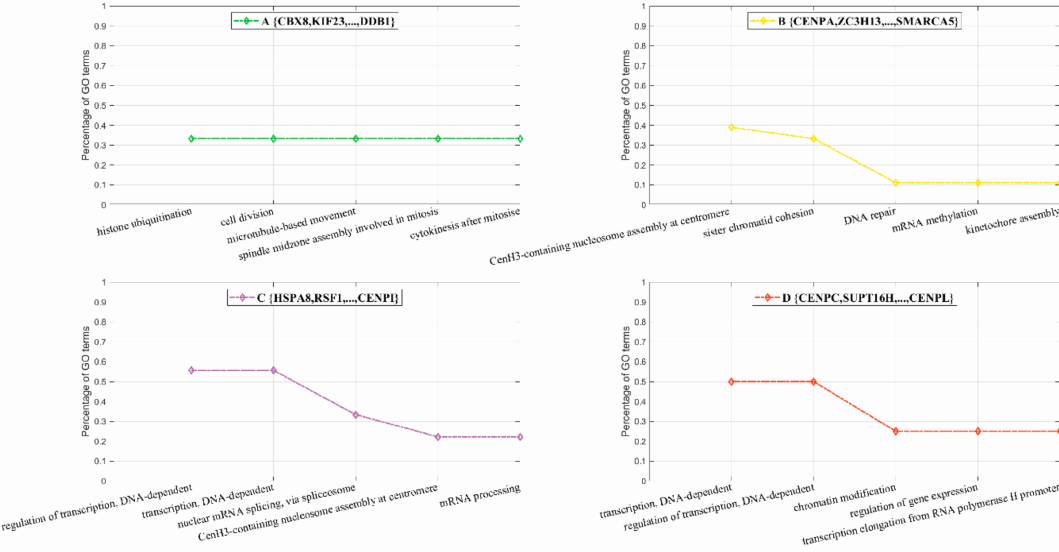
Figure 5. Gene ontology (GO) enrichment analyses of the sub-complexes ( A ) {CBX8, KIF23, ... , DDB1}; ( B ) {CENPA, ZC3H13, ... , SMARCA5}; ( C ) {HSPA8,RSF1, ... ,CENPI}; ( D ) {CENPC, SUPT16H, ... , CENPL} within the CEN complex inferred via the MMC